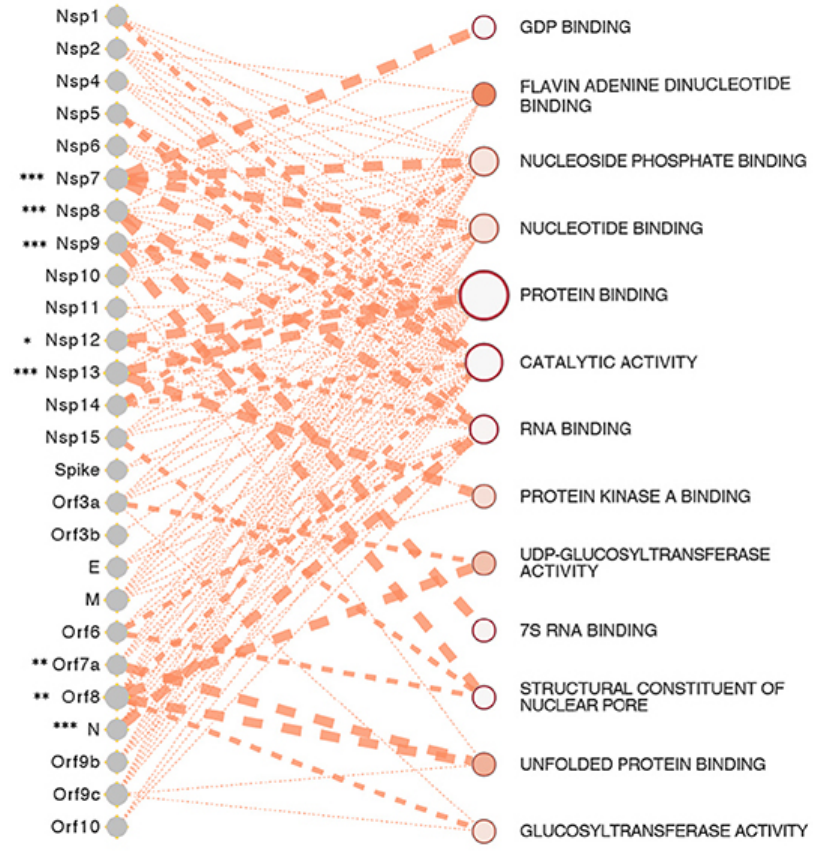
Figure 3. SARS-CoV-2 proteins and gene ontologies of their interacting host genes [31]. The size of the gene ontology is signified by the size of the circle which is proportional to the number of genes in the ontology, such as the genes relating to protein binding occupying the largest space in the interactome. The thickness of the lines linking SARS-CoV-2 proteins and gene ontologies represents the strength of the interaction of gene count between SARS-CoV-2 proteins and host genes in the ontology. SARS-CoV-2 proteins of significance, especially the ones interacting with a significantly higher number of host genes than expected are represented by asterisks, with representation: * P < 0.05, ** P < 0.01, *** P < 0.001 Note. Reprinted from “Epigenetic Lens to Visualize the Severe Acute Respiratory Syndrome Coronavirus-2 (SARS-CoV-2) Infection in COVID-19 Pandemic,” by Saksena N, Bonam SR, Miranda-Saksena M. Front Genet. 2021 Mar 22;12:581726